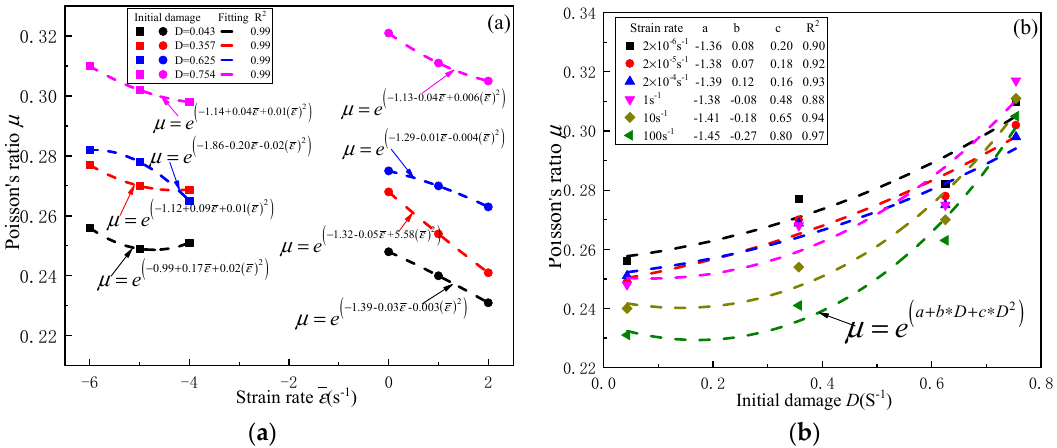
Figure 11. Plot of Poisson’s ratio versus initial damage for the axial test from 2 × 10 − 6 s − 1 to 100 s − 1 levels of strain rate: ( a ) μ −𝜀̅ ; ( b ) μ -D .